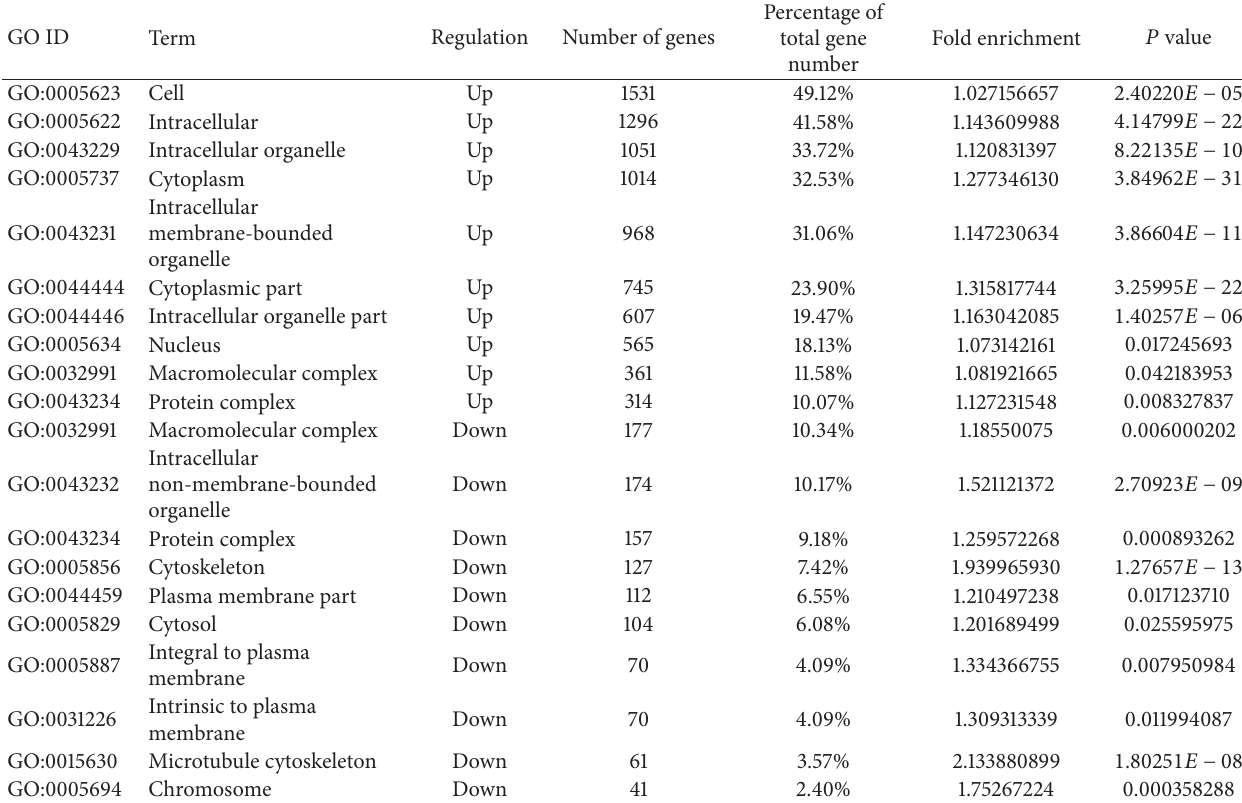
Table 4: GO analysis of RA SMSCs with different cellular components related to differentially expressed